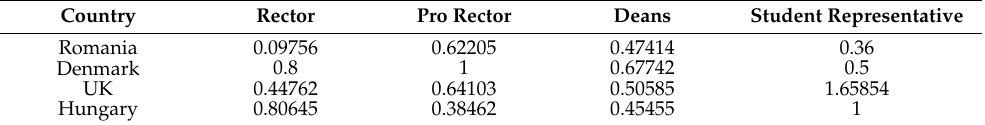
Table 1. Ratios of women to men in leadership positions (columns) across the four countries (rows). Country